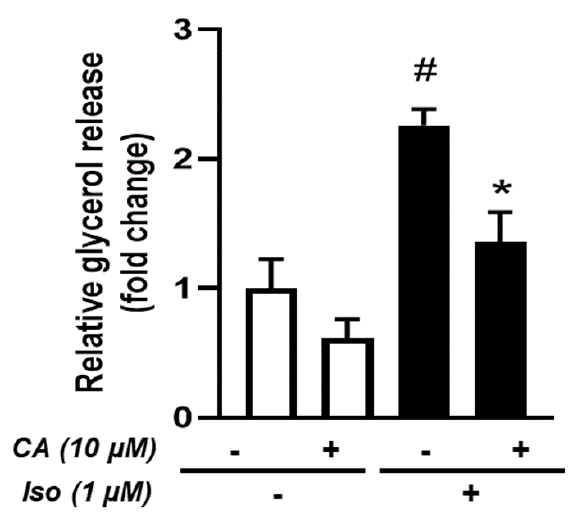
Figure 6. Effects of CA on lipolysis : conversion of hMADS adipocytes into brite adipocytes was induced in the absence ( − ) or the presence ( + ) of 10 µ M CA for 4 days. Basal and isoproterenol-induced lipolysis were measured during the last hours. Data are displayed as mean ± SEM of three independent experiments; paired student, p < 0.05 was considered significant: #, no isoproterenol challenge (iso − ) vs. isoproterenol treatment (iso + ); * , untreated vs. CA-treated condition.